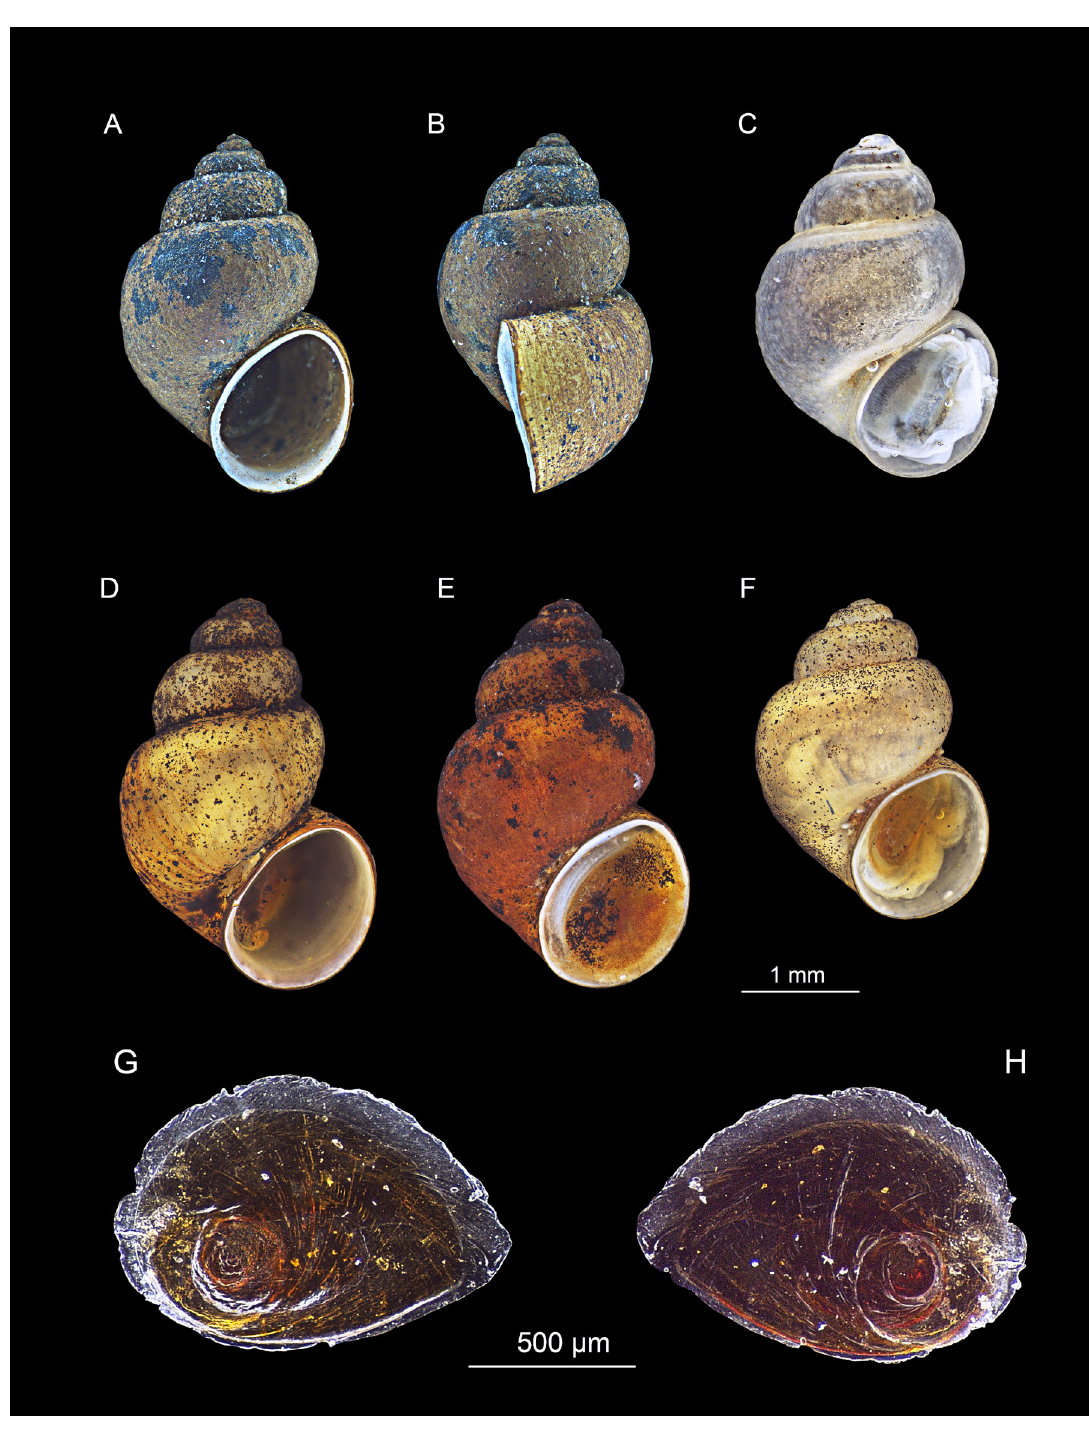
Fig. 20. Shells and operculum of Mercuria carrillorum Miller, García-Guerrero & Ramos sp. nov. A – B . Holotype (MNCN 15.05/200175H), frontal and lateral views. D, G–H . Paratypes (MNCN 15.05/94748). C . Manantial de los Doce Pilares Spring, Málaga, Spain. D . Stream in Canuto de la